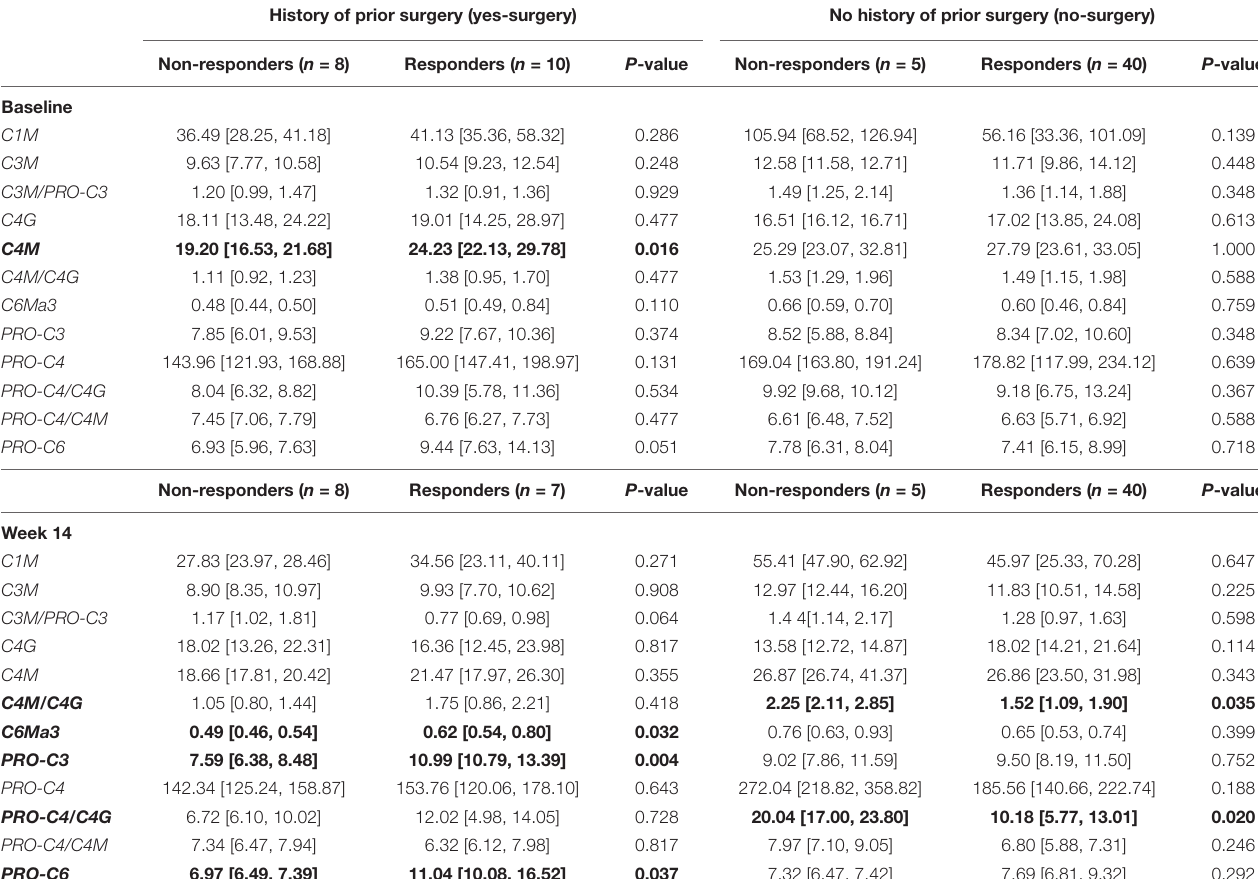
TABLE 3 | Serum biomarker levels of the cohort stratified by history of surgery and further by response to treatment, both at baseline and week 14. History of prior surgery (yes-surgery) No history of prior surgery (no-surgery)